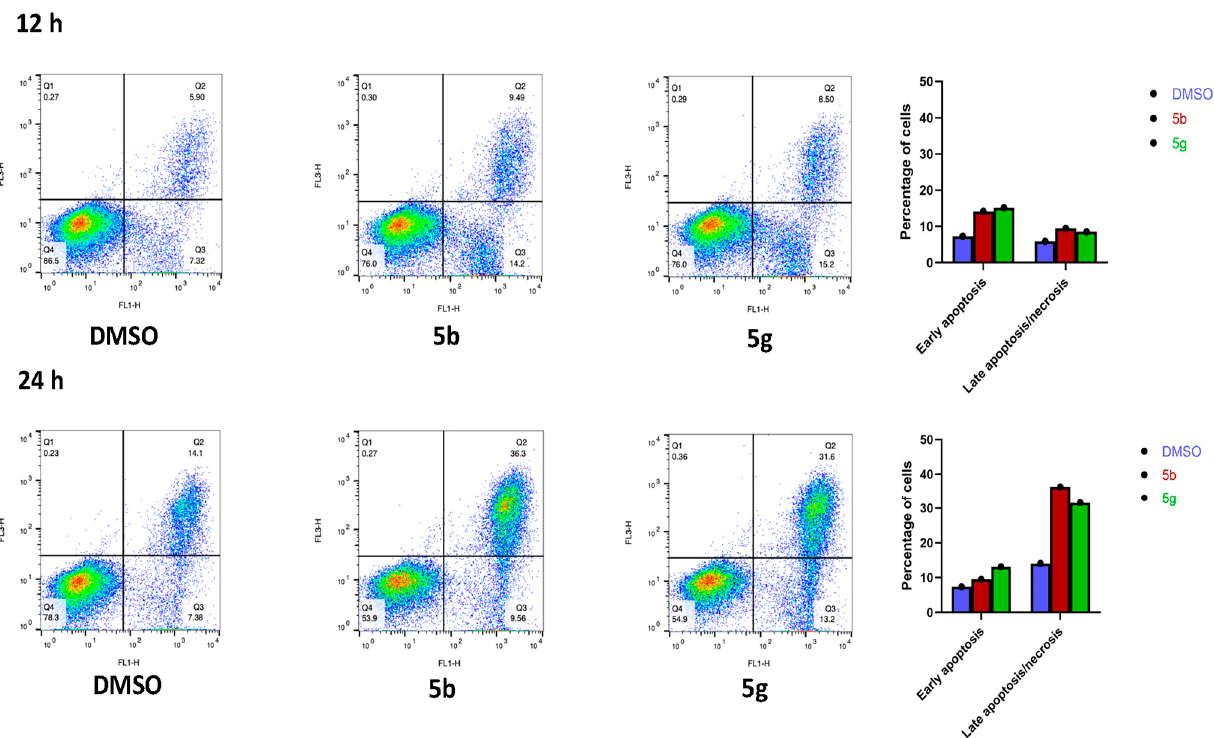
Figure 3. Apoptosis analysis of 5b and 5g using Annexin V-FITC (FL1-H)/7-AAD (FL3-H) dual staining in HL-60 cells.